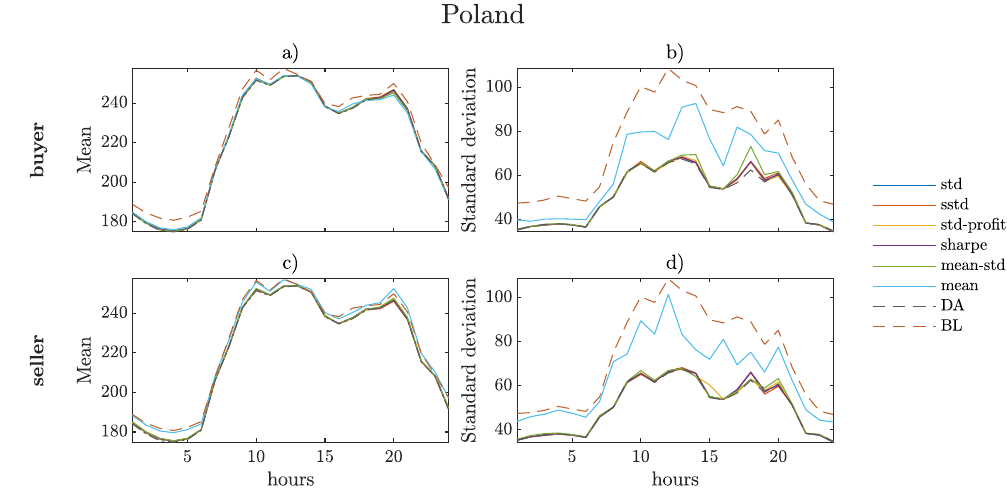
Figure 6. Means (for buyer—panel ( a ) and for seller—panel ( c )) as well as standard deviations (for buyer—panel ( b ) and for seller—panel ( d )) of hourly prices in the validation window obtained from different strategies in the Polish market. For reference, also the results of trading only on the day-ahead (DA) or balancing (BL) market are plotted with dashed lines. Source: Authors’